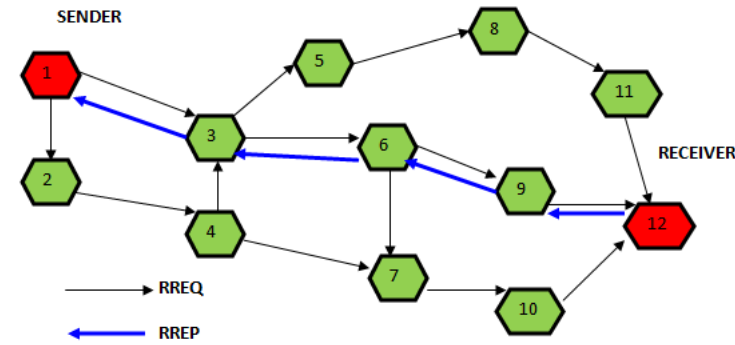
Figure 1. AODV Route Discovery Process.